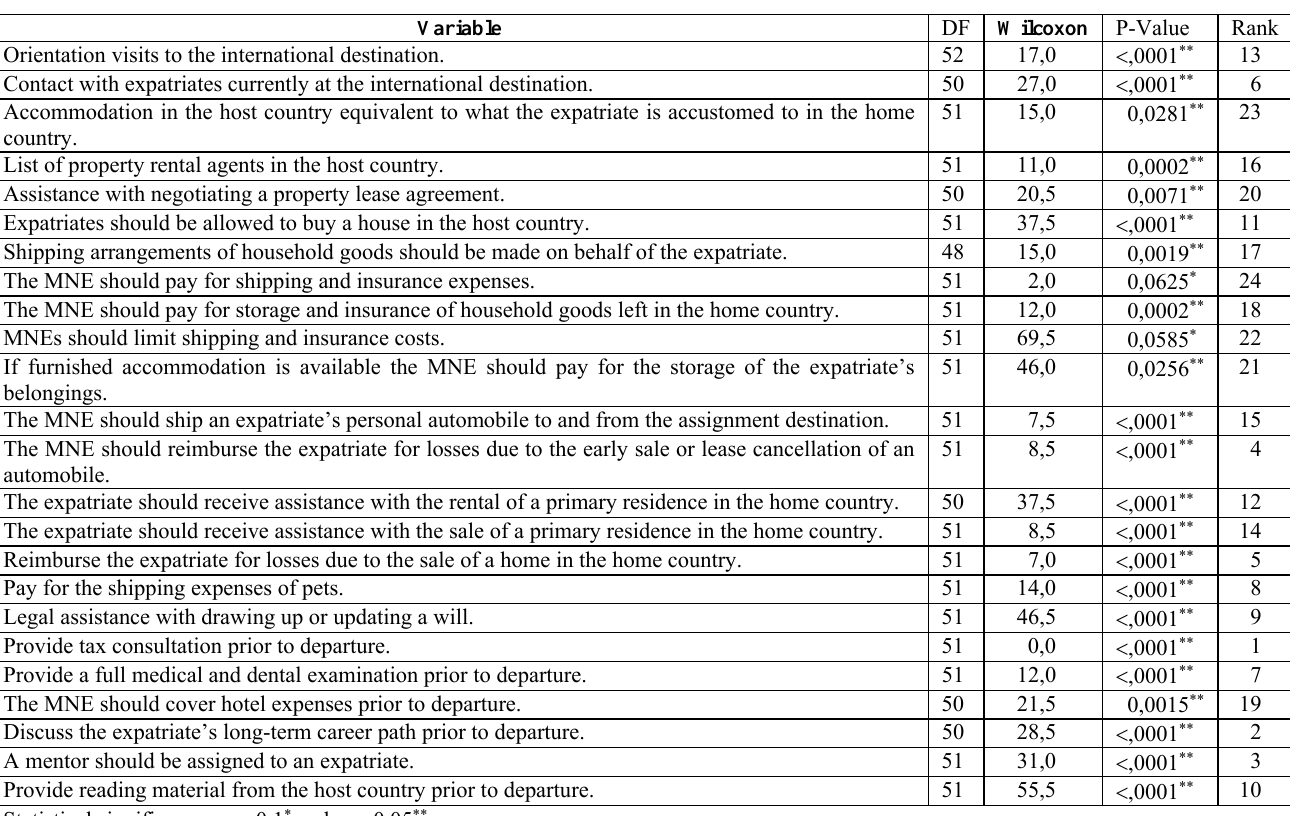
Table 2: Wilcoxon test for preparation required vs.